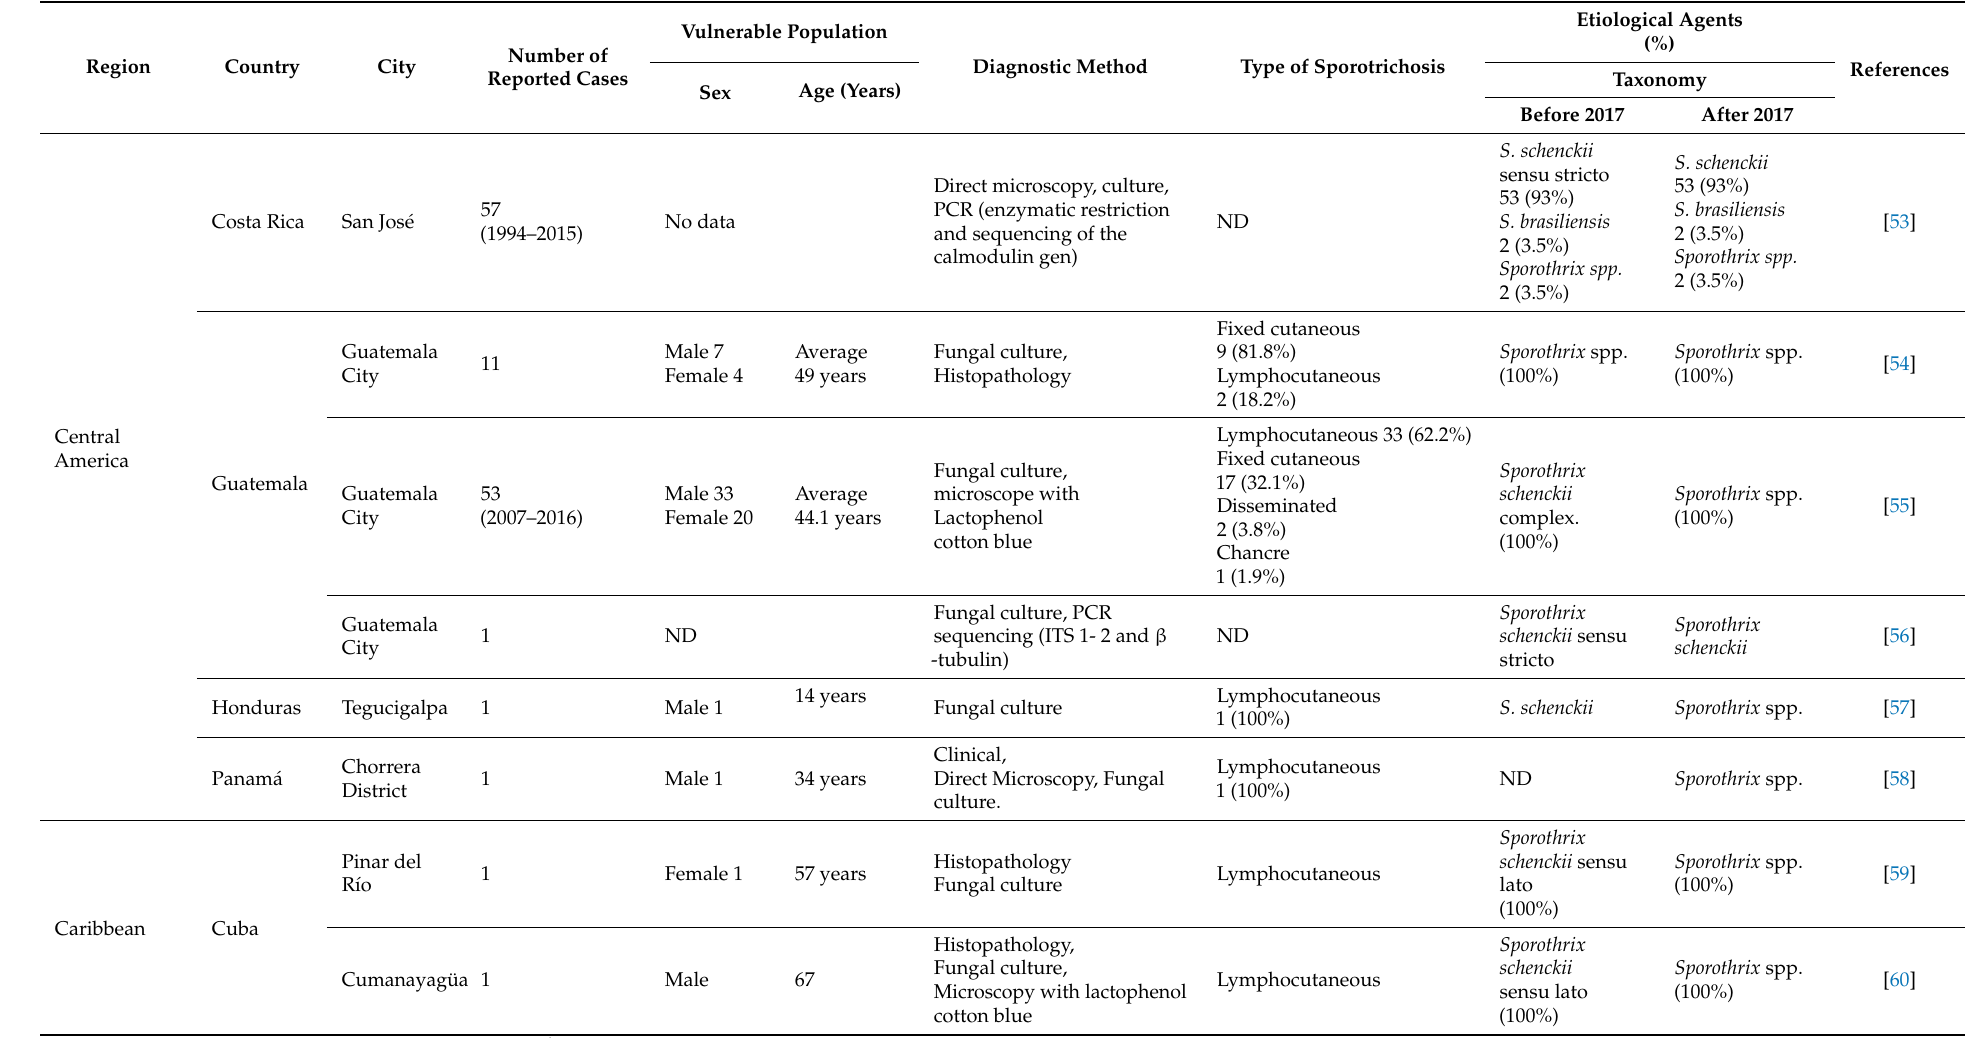
Table 2. Epidemiology of Sporotrichosis in Central America and the